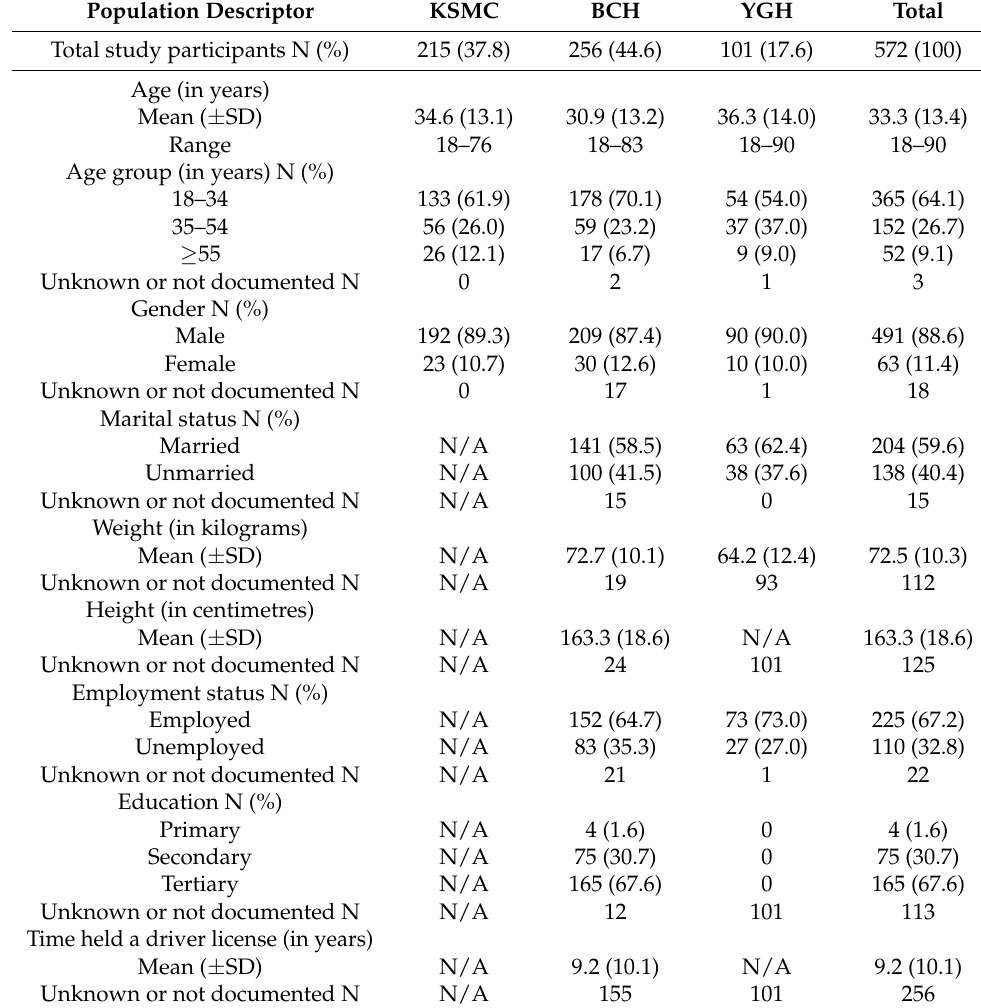
Table 1. Characteristics of the study